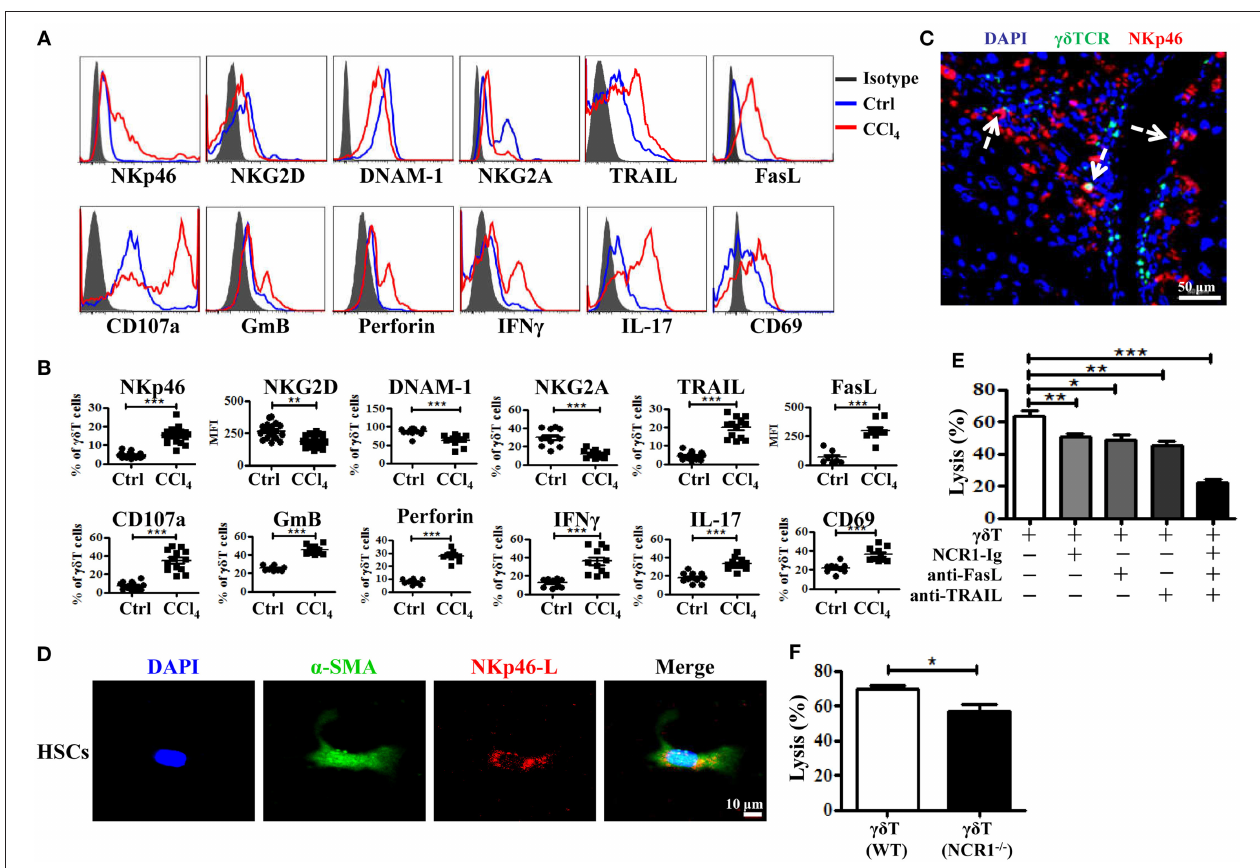
FIGURE 4 | Hepatic γδ T cells exhibit strong cytotoxic potential upon chronic liver injury. (A) Representative histograms of NKp46, NKG2D, DNAM-1, NKG2A, TRAIL, FasL, CD107a, GmB, perforin, IFN γ , IL-17, CD69 expression on hepatic γδ T cells from WT mice treated with corn oil (Ctrl) and CCl 4 . (B) The statistical percentages or mean fluorescence intensity (MFI) are shown ( n = 10–15). (C) Representative immunofluorescence double staining image of frozen liver fibrotic sections ( n = 3) stained for γδ T cells ( γδ TCR + , green) and NKp46 (NKp46 + , red) and counterstained with DAPI (blue). Scale bars, 50 µ m. Arrows indicate γδ TCR and NKp46 double positive cells. (D) Representative images of culture-activated HSCs ( α -SMA + , green) in vitro which stained for NKp46-L with NCR1 Fc chimera (NCR1-Ig) (red) and counterstained with DAPI. Scale bars, 50 µ m. (E) The primary HSCs were isolated from WT mice, 5 days after adherent culture, co-cultured with isolated hepatic γδ T cells at an effector: target ratio of 2:1 in the presence or absence of NCR1-Ig, TRAIL-, or FasL-specific neutralizing antibodies for 12h, respectively. The cytotoxicity of hepatic γδ T cells against activated HSCs were measured using a lactate dehydrogenase (LDH) assay. (F) The hepatic γδ T cells isolated from CCl 4 -treated WT and NCR1 − / − mice were co-cultured with activated HSCs at an effector:target ratio of 2:1 for 12h, the cytotoxicity was measured using an LDH assay. * P < 0.05, ** P < 0.01, *** P < 0.001.